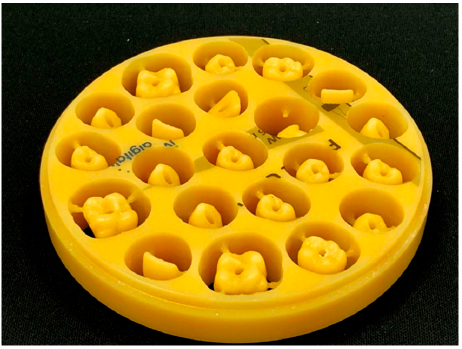
Figure 1. The hybrid crown abutments milled from IPS e.max multi-wax pattern (Ivoclar Vivadent, Shaan, Liechtenstein).